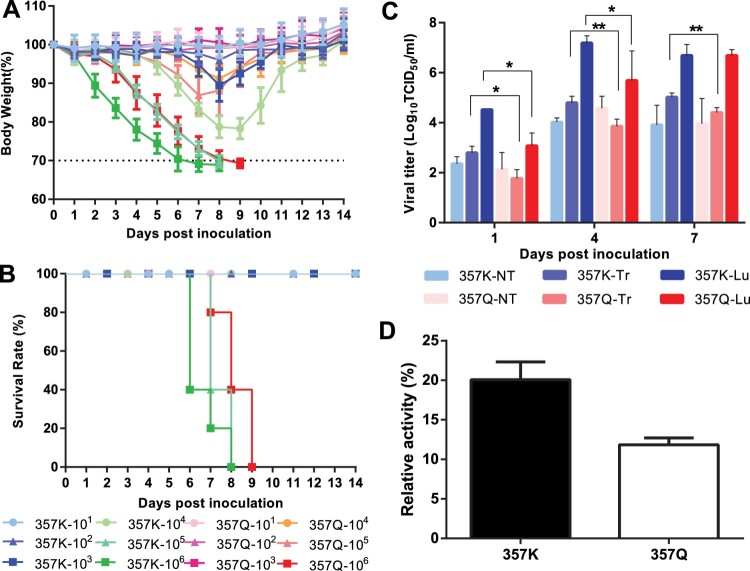
Morbidity, mortality, replication, and polymerase activity assays of rgHuN-WT (357K) and rgHuN-NPK357Q (357Q) viruses in mice. Female C57BL/6J mice (8–10 weeks old) were inoculated intranasally with 50 μl of PBS containing 101 TCID50–106 TCID50 of the recombinant virus rgHuN-WT or rgHuN-NPK357Q, or with PBS (mock), to evaluate virally induced morbidity (A) and mortality (B). Morbidity was assessed by bodyweight changes over a 14-day period and was graphed as a percentage of the average weight on the day of inoculation (day 0). The average bodyweight change in each group is shown with error bars representing the standard deviations (±). Mortality associated with infection with the recombinant virus rgHuN-WT (357K) or rgHuN-NPK357Q (357Q) was also examined. (C) Viral replication efficiency in the respiratory tracts of mice was analysed by inoculating mice (n = 3 per group per time point) intranasally with 105 TCID50 of the recombinant viruses. At 1, 4, and 7 days postinoculation, three mice in each group were euthanized. Tissues, including nasal turbinate (NT), tracheal tissue (Tr), and lung (Lu), were collected for virus titration. (D) Polymerase assay was conducted in 293T cells transfected with reporter plasmids pFluc (encoding firefly luciferase flanked by the noncoding regions of the influenza NP segment to produce an artificial influenza-NP-like RNA segment), pRluc (pRL-TK, encoding Renilla luciferase, for normalization), and expression plasmids encoding PB2, PB1, PA, and NP. 357K, wild-type virus carrying NP-357K; 357Q, virus carrying NP-357Q. *p < .05; **p < .01.